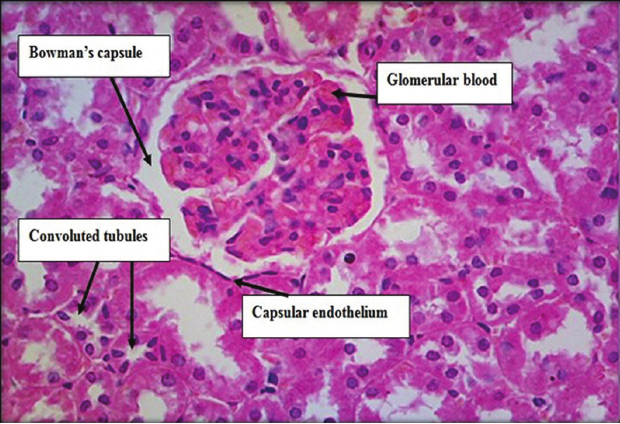
FIGURE 8 - Effect of normal saline on the kidneys of rats (H & E, 400x, 5 µ): Representative image of kidney of rats treated with normal saline orally for three weeks showing thin walled endothelium of Bowman’s capsule, glomerulus with intact cellular borders, blood perfusion and convoluted